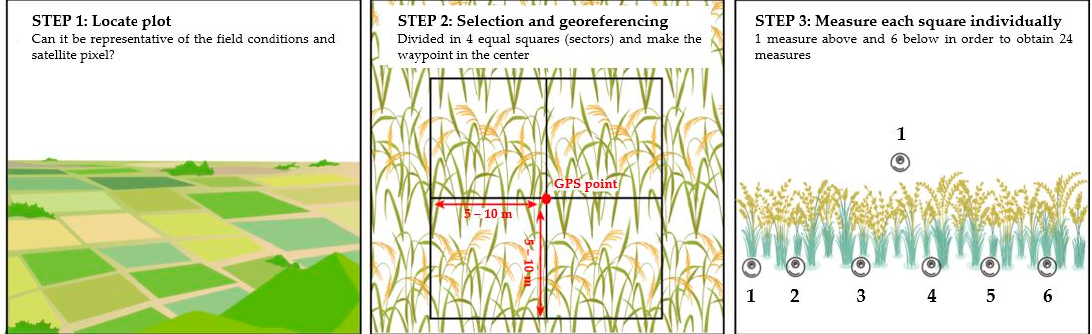
Figure 2. Workflow for collecting in situ LAI measurements using the Li-Cor LAI 2200C Plant Canopy Analyzer. Step 1 is the selection of the field; in Step 2 the GPS point, representative of the center of the ESU, is taken; and in Step 3 the measurements are performed obtaining an LAI value as a mean value of the 24 measurements below the canopy (six for each square).